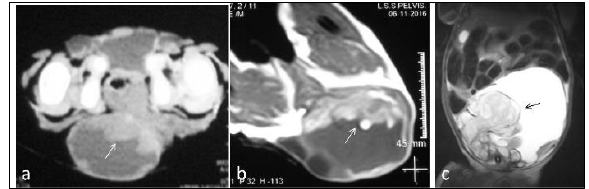
Figure 6: Subtype C3 of the predominantly cystic SCT; the cyst cavity is marked by an arrow that is pointing to its character- istic irregular internal wall thickening . a) CT scan of a 10- month-old boy (coccygeal mass). b) MRI axial T1WI of a 2- month-old girl (coccygeal mass). c) MRI coronal T2WI of a 25- day-old female; note the marked intra-abdominal extension of the tumor, with 'fungating' internal wall thickening (black ar- row).